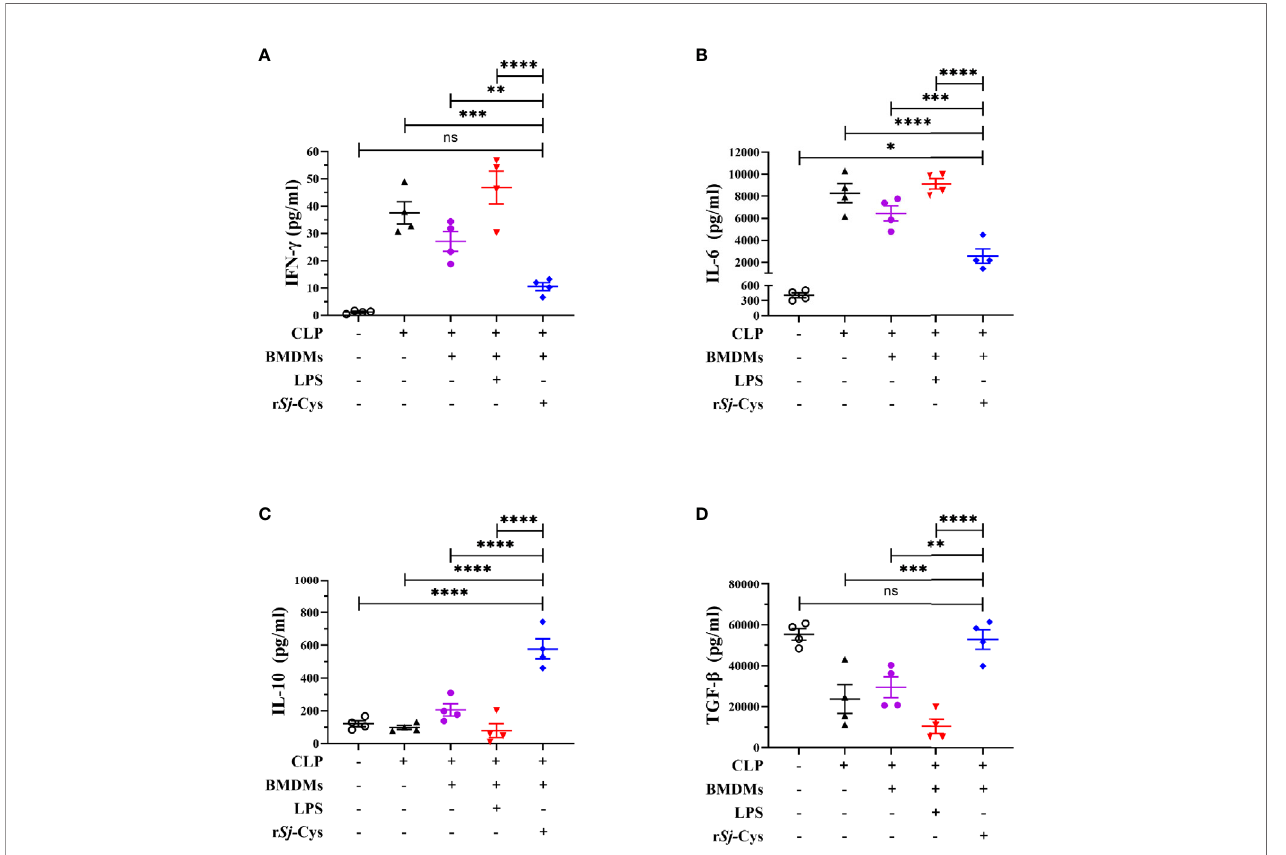
FIGURE 5 | r Sj -Cys treated-BMDMs downregulated pro-in fl ammatory cytokines and upregulated regulatory cytokines in mice with sepsis. The levels of IFN-gamma (A) , IL-6 (B) , IL-10 (C) , and TGF- b (D) were measured in the sera of mice in each group using ELISA. n = 4. The results are presented as mean ± SEM. ns, not signi fi cant, * P < 0.05, ** P < 0.01, *** P < 0.001, **** P <